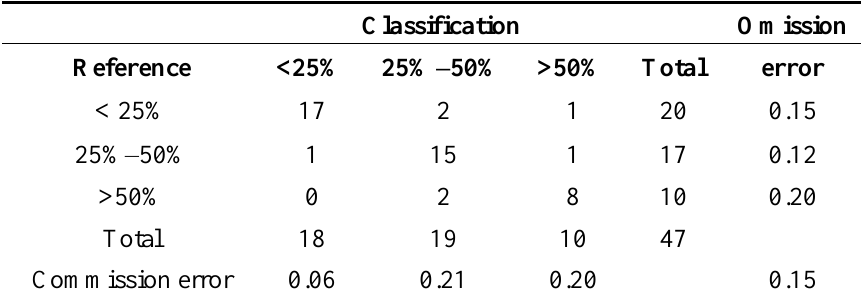
Table 4. Confusion matrix, model B (NDVI & post-fire LiDAR).